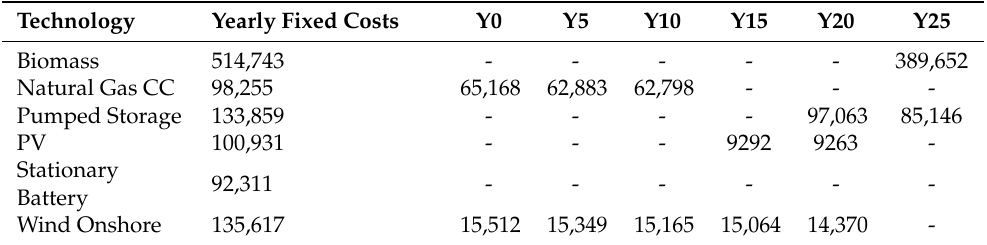
Figure 10. Delta of capacities between myopic and perfect foresight case in iteration 0. Table 3. Mark-ups on investment cost in iteration 1 for each year (perfect foresight) [EUR/MW].